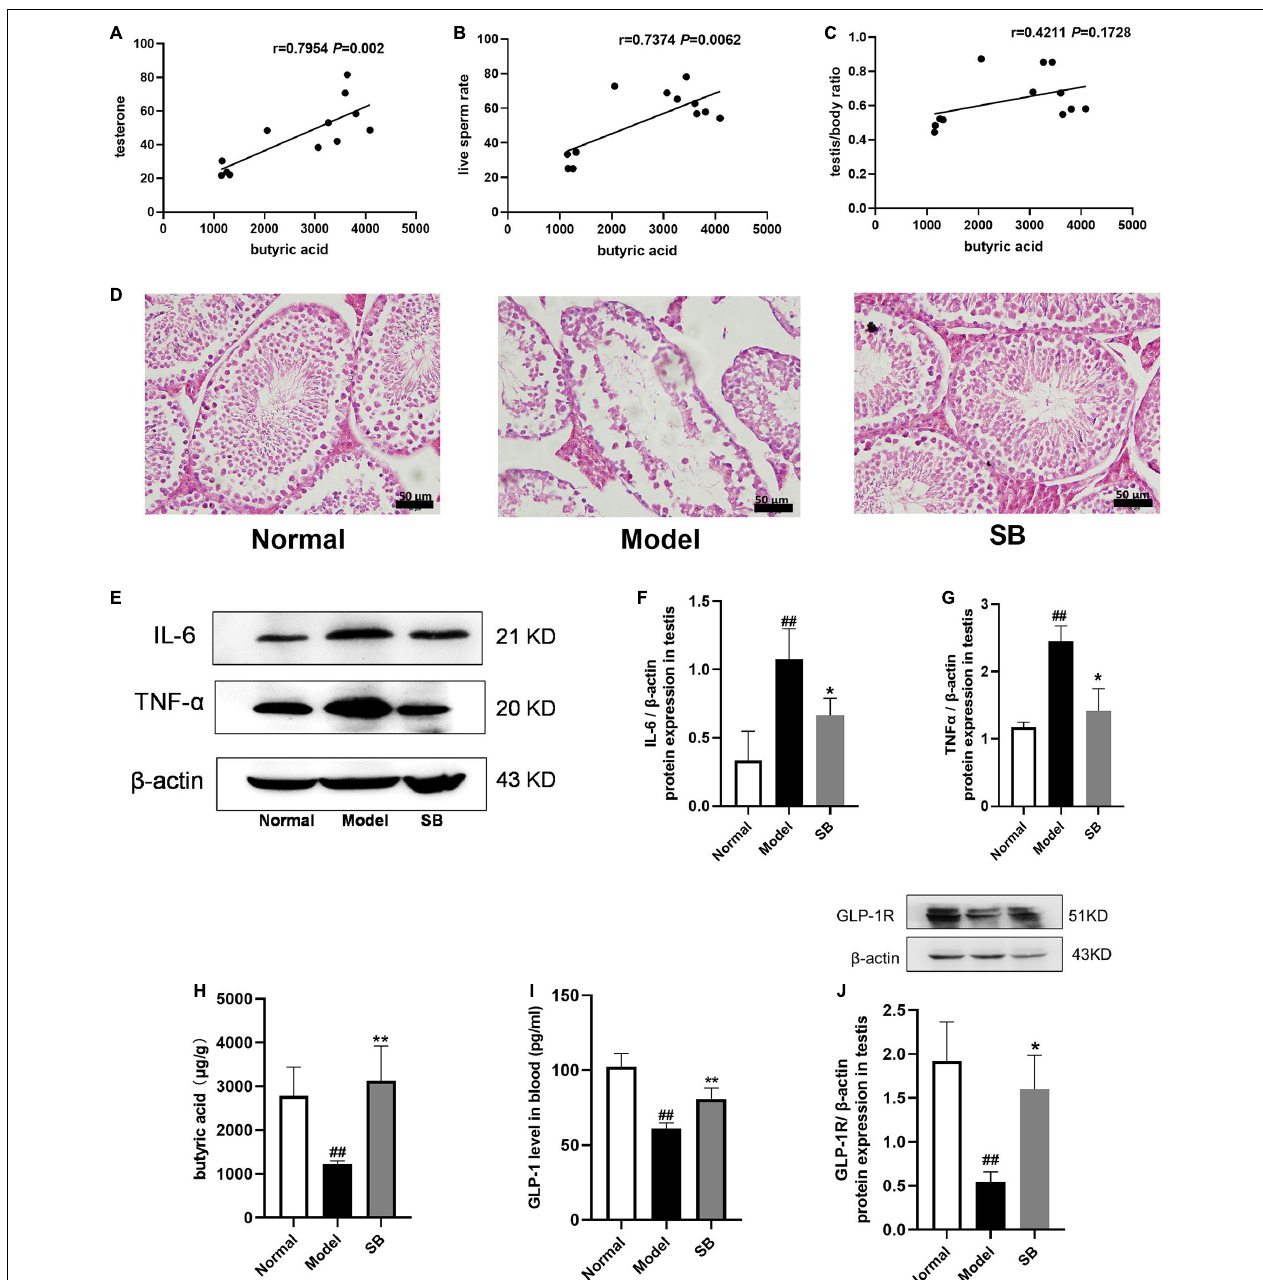
FIGURE 9 | The effects of sodium butyrate on testicular damage and inflammatory responses in DM mice. (A–C) Correlation of butyric acid with sperm damage indicators. (D) H&E staining of mice testicular tissues ( n = 4). Scale bar, 50 µ m. (E–G) The expression of IL-6 and TNF- α in testicular tissue of DM mice ( n = 3). (H) The level of butyric acid in feces ( n = 5). (I) GLP-1 level in blood ( n = 4). (J) The expression of GLP-1R in testis ( n = 3). Data are expressed as mean ± SD. ## P < 0.01 vs. normal group. * P < 0.05; ** P < 0.01 vs. model